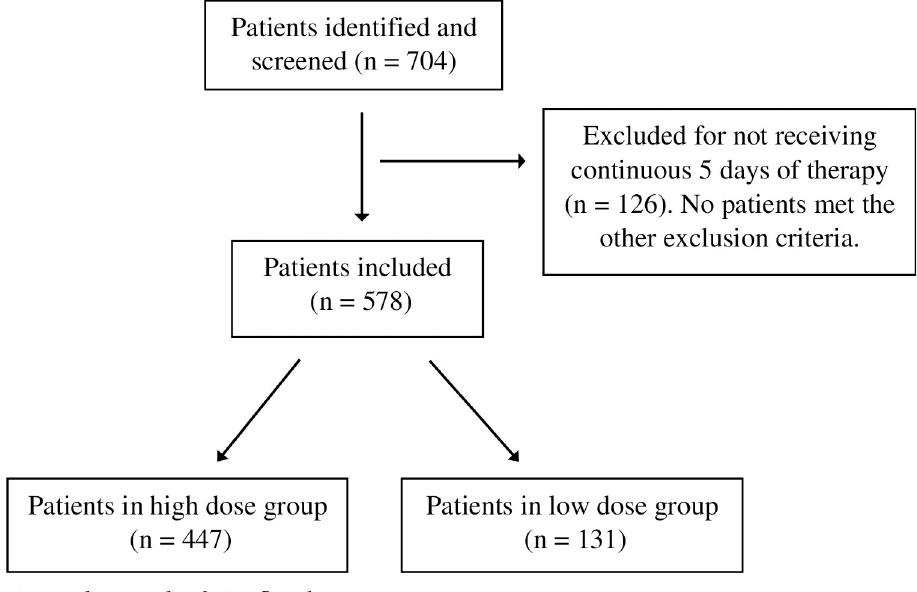
Fig 1. Inclusion and exclusion flow